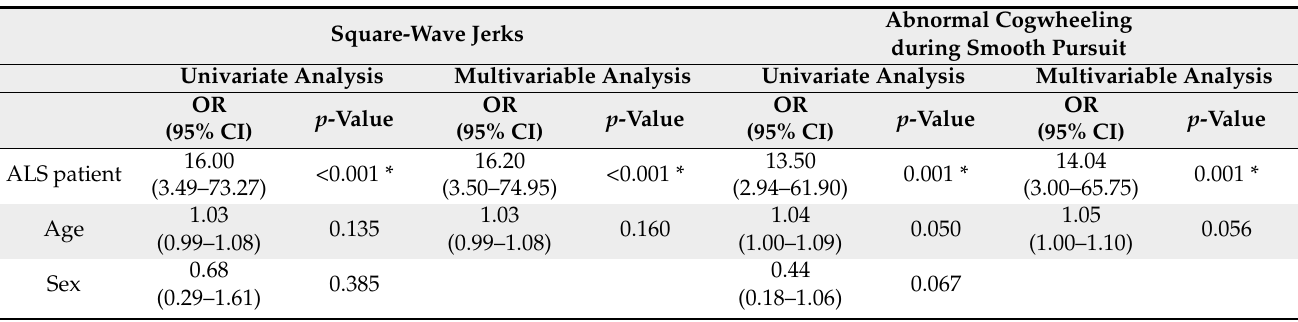
Figure 1. Examples of eye movement abnormalities in our ALS patients. Abbreviations: OD, oculus dexter; OS, oculus sinister. ( A ) Square-wave jerks, ( B ) abnormal cogwheeling during smooth pursuit, and ( C ) saccadic hypometria. Table 3. Univariate and multivariate logistic regression analyses between clinical data and oculomotor performance of ALS patients and control